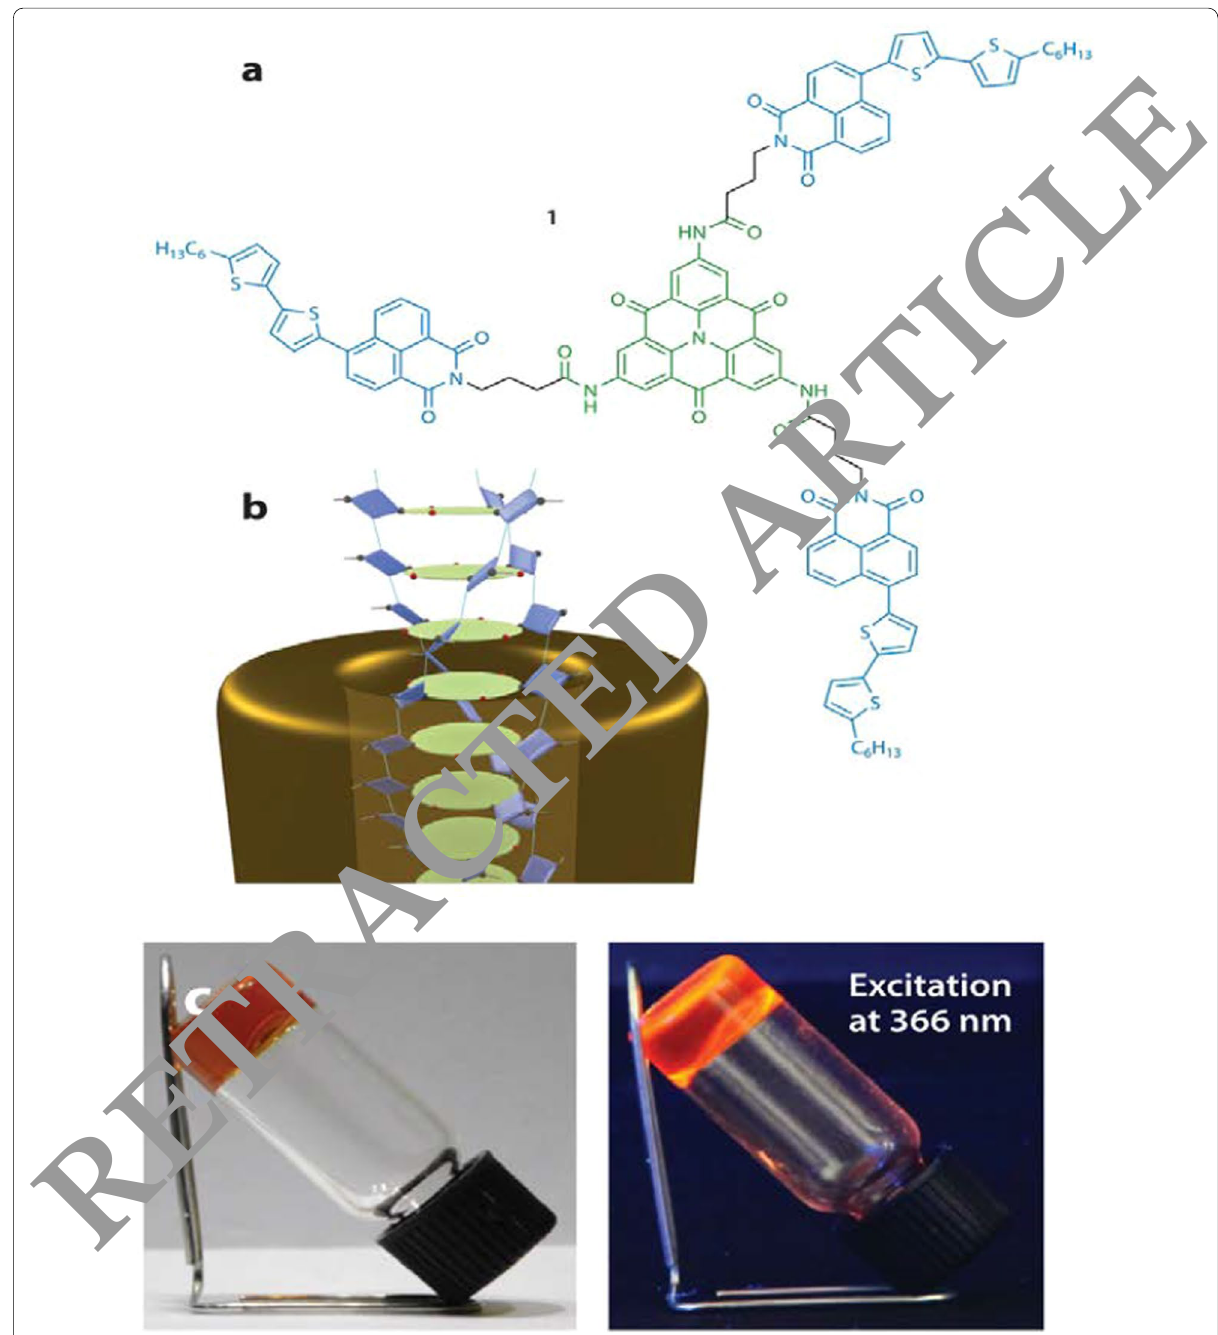
Fig. 3 a Molecular structure of a conductive gel with electron donor and electron acceptor chromophores; b a nanofiber whose core consists of a regular array of electron donor and electron acceptor chromophores. These molecules are sensitive to ultraviolet light, and when the beam hits the gel, electron excitation occurs and part of the input spectrum is absorbed by the material. Absorption of this spectrum of light causes the color of this material to change; c the macroscopic image of the gel which has changed color due to contact with ultraviolet light [1,